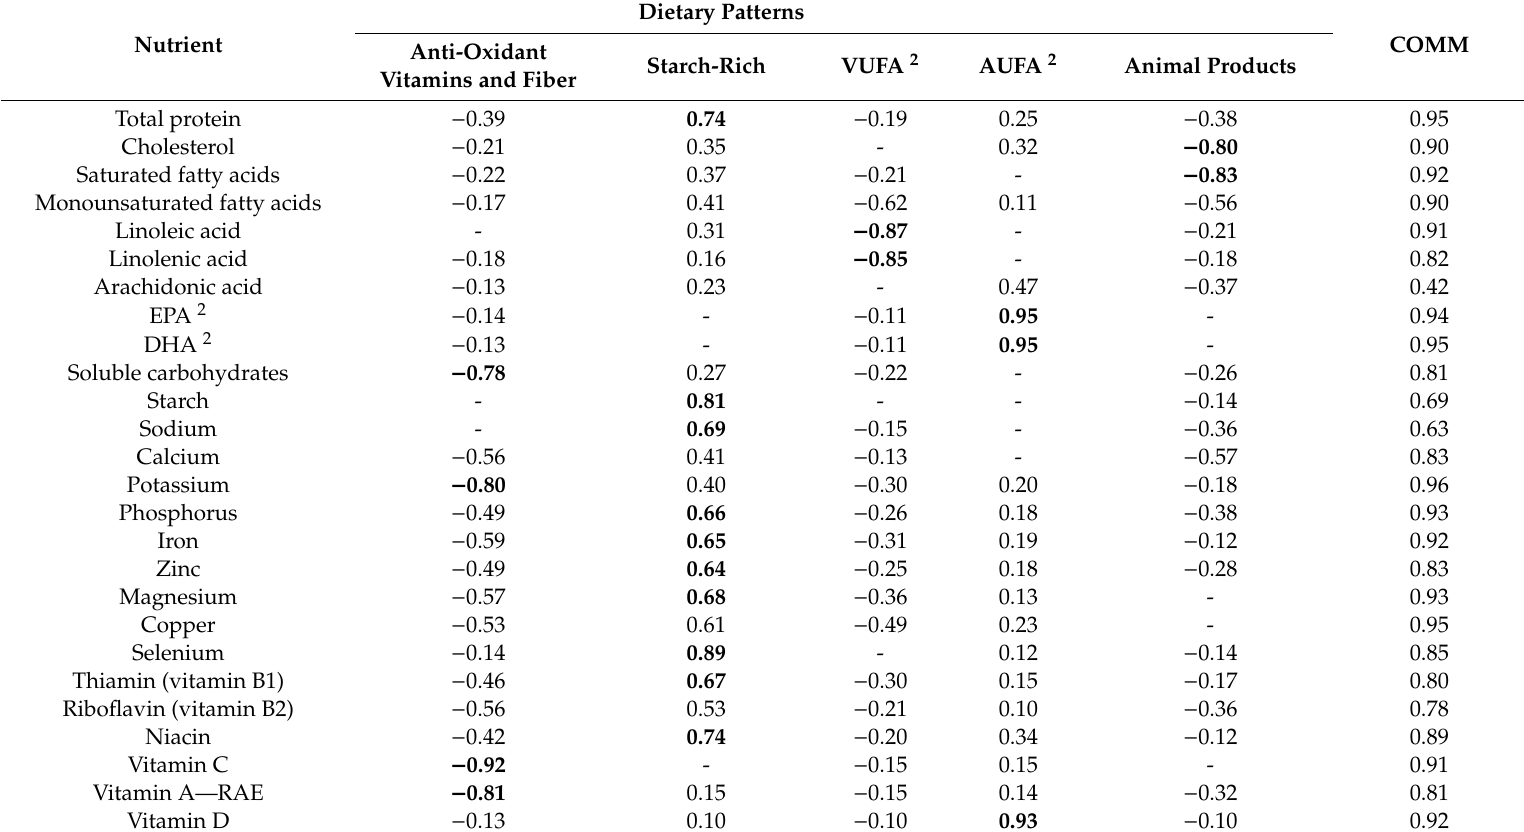
Table 1. Factor loading matrix 1 , communalities (COMM) and explained variances (VAR) for the five major dietary patterns identified by principal component factor